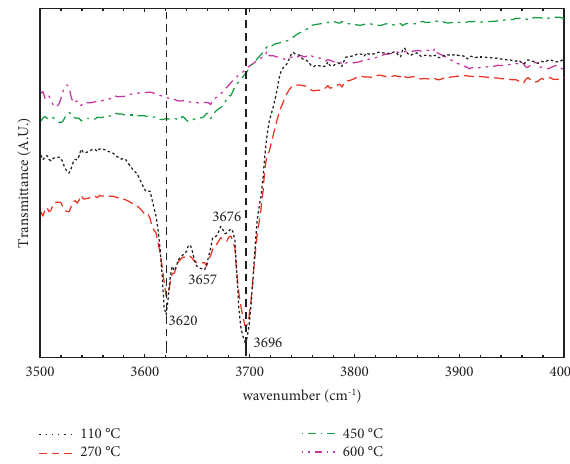
Figure 12: Magnified version of Figure 11 in the range 3500–4000cm − 1